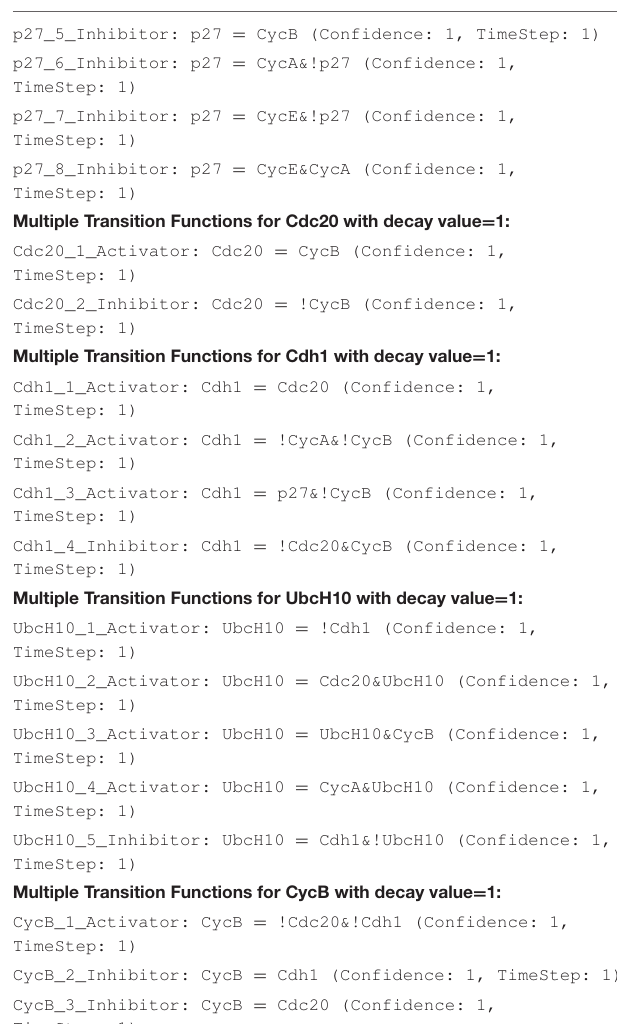
TABLE 1 | Inferred FBN cell cycle network.